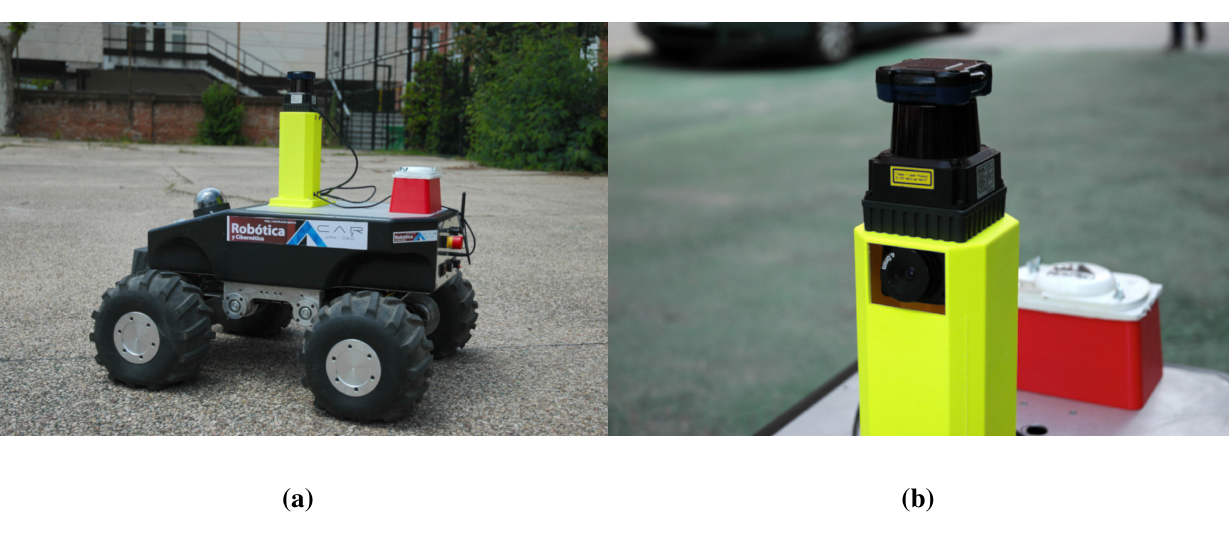
Figure 6. Platform and sensors used in experiments. ( a ) Summit XL mobile platform; ( b ) Hokuyo laser range finder above the Firefly